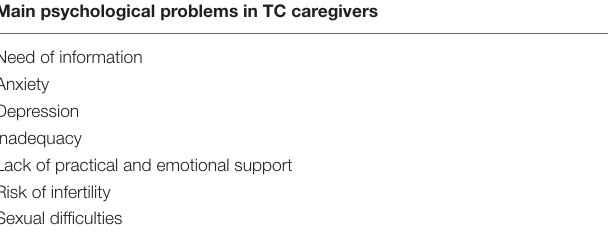
TABLE 2 | Main psychological issues in TC caregivers. TABLE 3 | Differences in emotional burden between TC patients and their